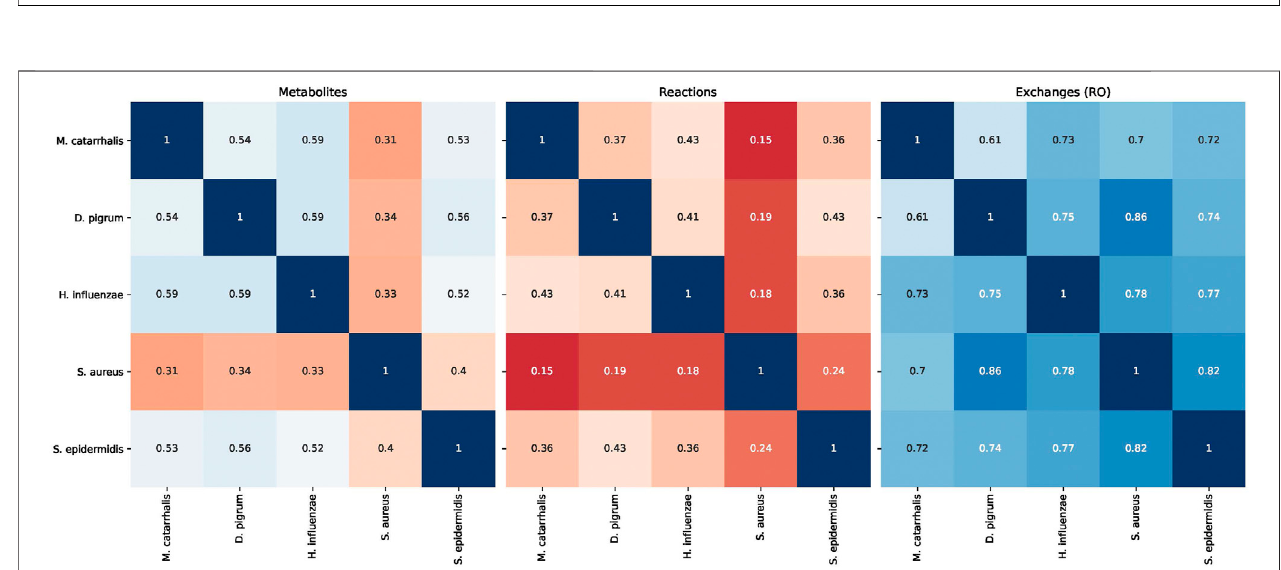
FIGURE4| Majorplayer withinacommunityiswhatamodelmust uptake andwhatitcanproduce. Producedmetabolites canbene fi tothercommunity members, namely Dolosigranulum pigrum , Haemophilus in fl uenzae , Staphylococcus aureus , Staphylococcus epidermidis , and Moraxella catarrhalis . However, too many shared uptakes can lead to competition within the community (resource overlap).